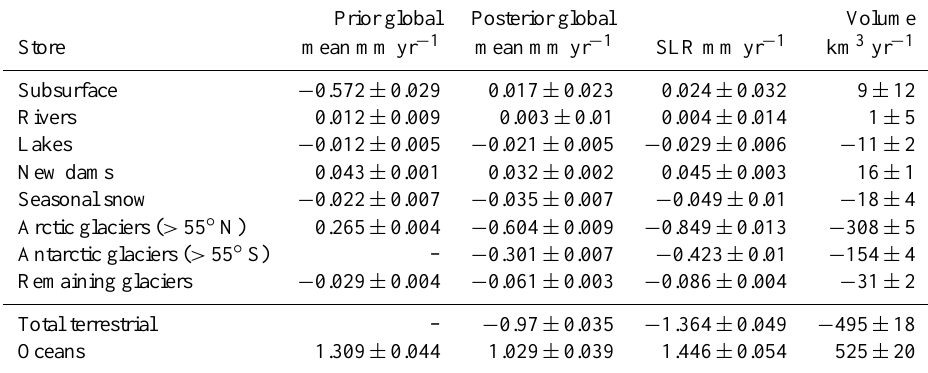
Table 3. Calculated linear trends in global mean seasonally adjusted anomalies associated with different water cycle components for 2003– 2012. The posterior trend estimates are also expressed in equivalent sea level rise (SLR) and volume. Second number is standard